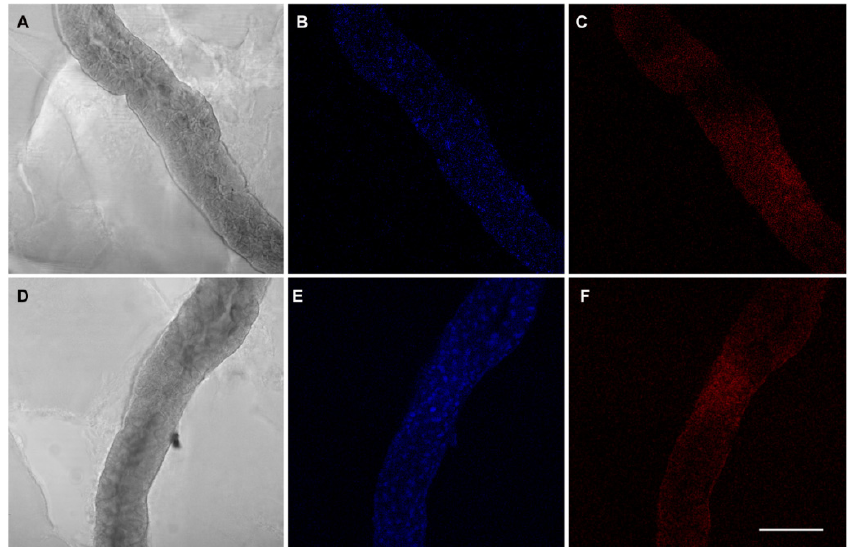
Figure 2. Whole mount fluorescence in situ hybridization on midgut samples from E. variegatus individuals after an AAP as adults. Exemplificative micrographs show the results corresponding to IAP 2 ( A – C ) and IAP 4 ( D – F ). Interferential contrast micrographs of the midguts are shown in A and D; 4 ′ , 6-diamidino-2-phenylindole (DAPI) staining of midgut tissues is reported in B and E; hybridization with the 16SrV phytoplasma-specific probe is shown in C and F. Bar = 100 μ m.